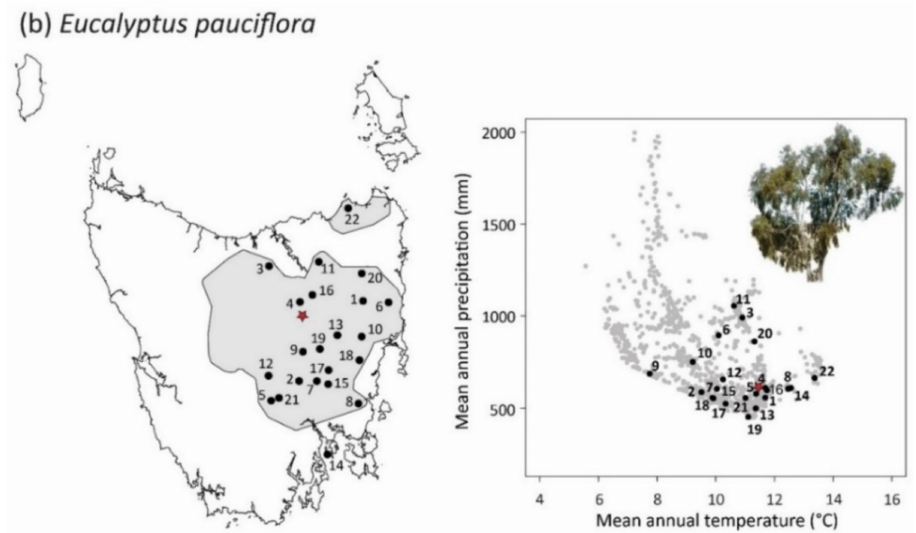
Figure 4. Maps of the Tasmanian geographic range and climate space for: ( a ) E. ovata , and ( b ) E. pauciflora , showing the distribution of the sampled 22 paired-localities (black points; see Table S3) and the common-garden site (red star). The climate plots show the mean annual precipitation (RANN) and temperature (TANN) of the populations included in this study, superimposed on distributional records of each species, obtained from the Natural Values Atlas (accessed August 2015). (Images: P.A.